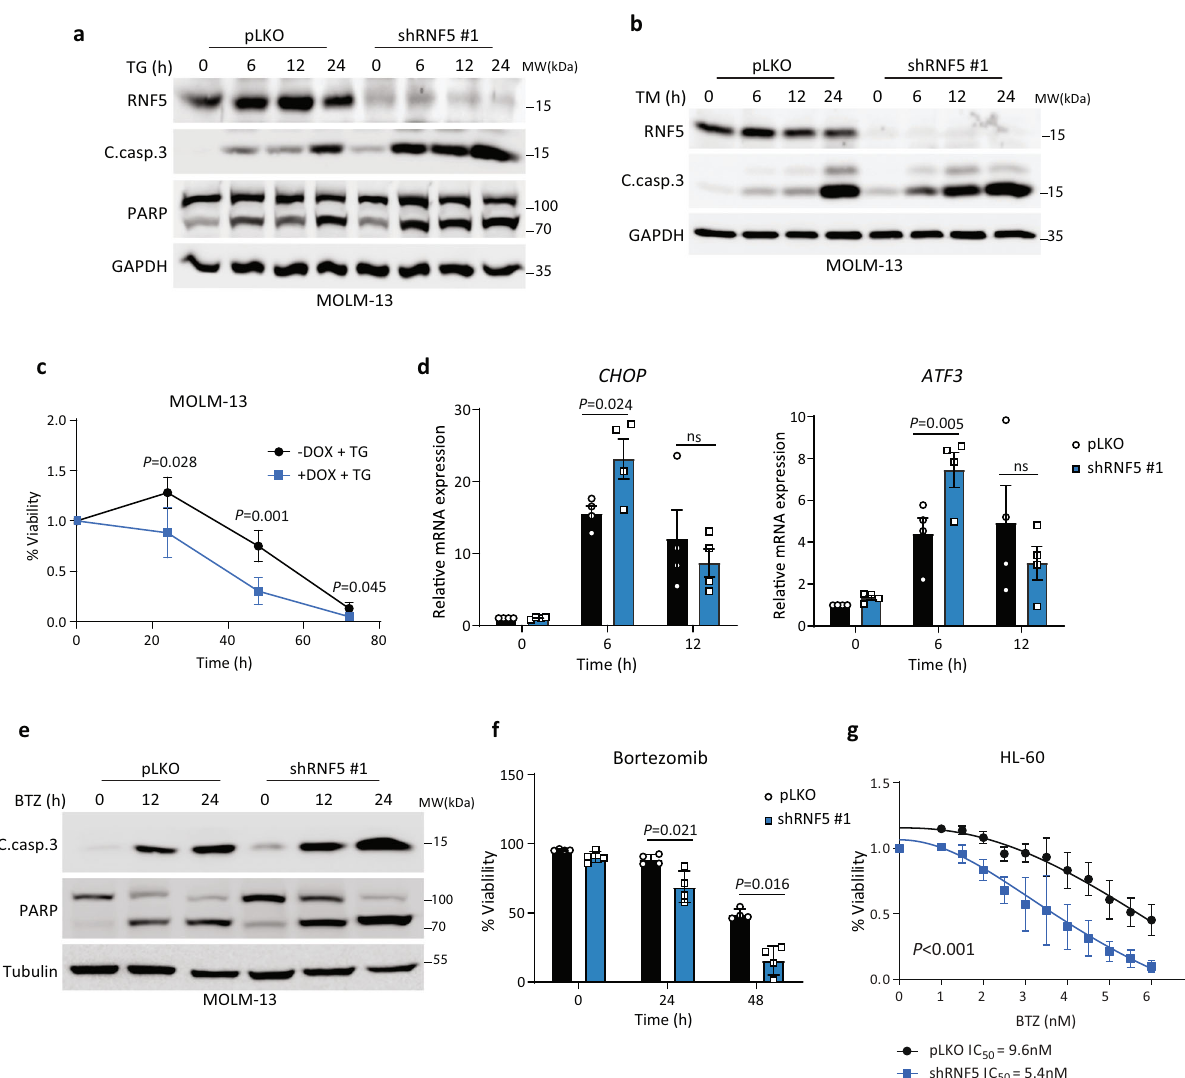
Fig. 3 RNF5 inhibition sensitizes AML cells to ER stress-induced apoptosis. a, b Western blot analysis of indicated proteins in MOLM-13 cells expressing empty vector (pLKO) or shRNF5 #1 and treated with thapsigargin (TG, 1 µ M) ( a ) or tunicamycin (TM, 2 µ g/ml) ( b ) for indicated times. c Luminescence- based viability assay of MOLM-13 cells expressing inducible shRNF5 and treated with or without doxycycline (DOX, 1 µ g/ml) for 3 days before treatment with TG (100 nM) for indicated times. d RT-qPCR analysis of CHOP and ATF3 mRNA in MOLM-13 cells expressing pLKO or shRNF5 #1 and treated with TG (100 nM) for indicated times. e Western blot analysis of cleaved caspase-3 (C.casp.3) and PARP in MOLM-13 cells expressing pLKO or shRNF5 #1 and treated with bortezomib (BTZ, 5 nM) for indicated times. f Fluorescence-based viability assay of HL-60 cells expressing pLKO or shRNF5 and treated with BTZ (5 nM) for indicated times. Cell viability was determined by fl ow cytometry of cells stained with annexin V conjugated to fl uorescein isothiocyanate and propidium iodide. g Luminescence viability assay of HL-60 cells expressing pLKO or shRNF5 and treated 48 h with indicated concentrations of BTZ. Data are presented as the mean ± SD ( c , f , and g ) or SEM ( d ) of n = 3 ( c and g ), n = 5 ( d (left)), or n = 4 ( d (right) and f ) independent experiments. P values were determined using paired two-tailed t -test ( c , d , and f ) or two-way ANOVA ( g ). ns: not signi fi cant. Source data are provided as a Source Data fi le. domain-dependent) and membrane association are both required (Fig. 6a). Endogenous RBBP4 coimmunoprecipitated with all RNF5 for an RNF5-mediated increase in RBBP4 ubiquitination. Corre- constructs, suggesting that both the RING and transmembrane spondingly, RNF5-KD in HEK293T or MOLM-13 cells decreased domains are dispensable for protein-protein interaction (Fig. 6b). RBBP4 ubiquitination relative to controls (Supplementary Fig. 6c, d). Reciprocal IP using RBBP4 as bait con fi rmed interaction with RNF5 Notably, neither RNF5 overexpression nor RNF5 KD altered (Fig. 6c). Interaction between endogenous RBBP4 and ectopically the abundance of RBBP4 protein, suggesting that RBBP4 expressed RNF5 was also con fi rmed in MOLM-13 cells (Fig. 6d). ubiquitination by RNF5 does not occur via the formation of Next, we assessed potential effect of RNF5 on RBBP4 ubiquitination. proteasome-targeting K48 ubiquitin chains and does not alter Co-expression of HA-tagged ubiquitin, Myc-tagged RBBP4, and RBBP4 stability (Fig. 6f, g and Supplementary Fig. 6e). Immu- Flag-tagged RNF5 constructs in HEK293T cells revealed that RBBP4 noprecipitation of RBBP4 and immunoblot using an antibody was ubiquitinated by WT RNF5, but not by RNF5 RM or RNF5 speci fi c for the K63 chain topology revealed no notable Δ CT (Fig. 6e), indicating that ubiquitin ligase activity (RING differences in cells overexpressing any form of RNF5, suggesting NATURE COMMUNICATIONS| (2021) 12:5397